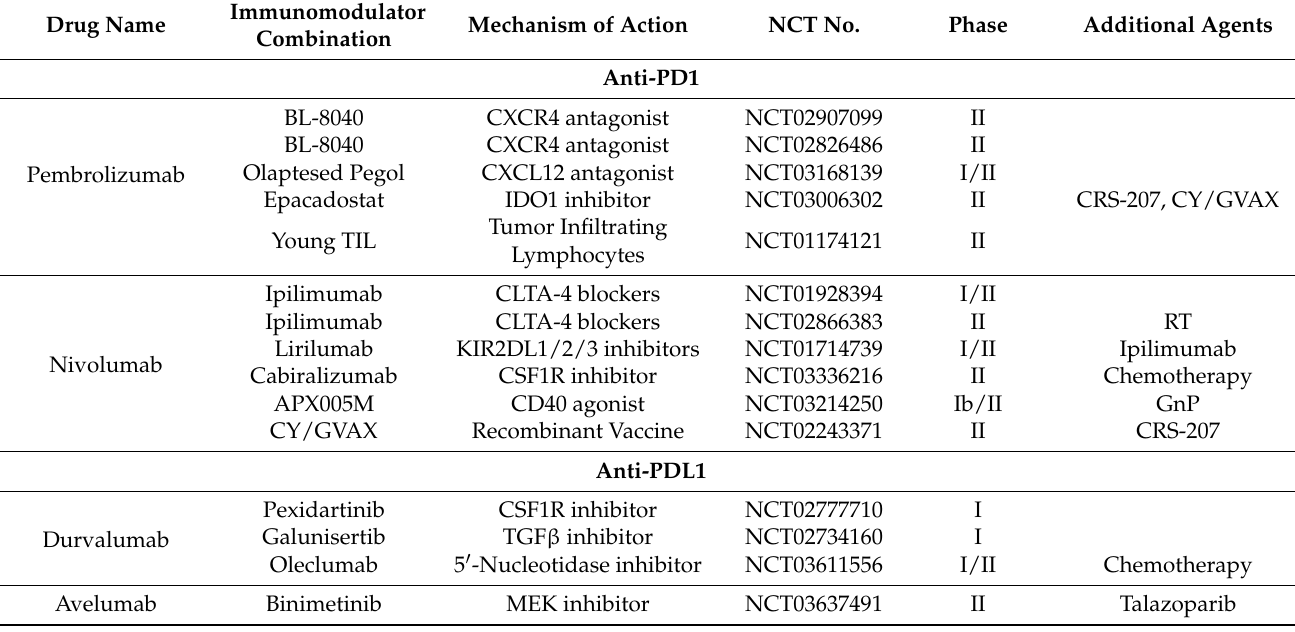
Table 3. Recent clinical trials designed to investigate the role of anti PD1/PDL1 monoclonal antibodies in association with other immunomodulatory therapies in PDAC